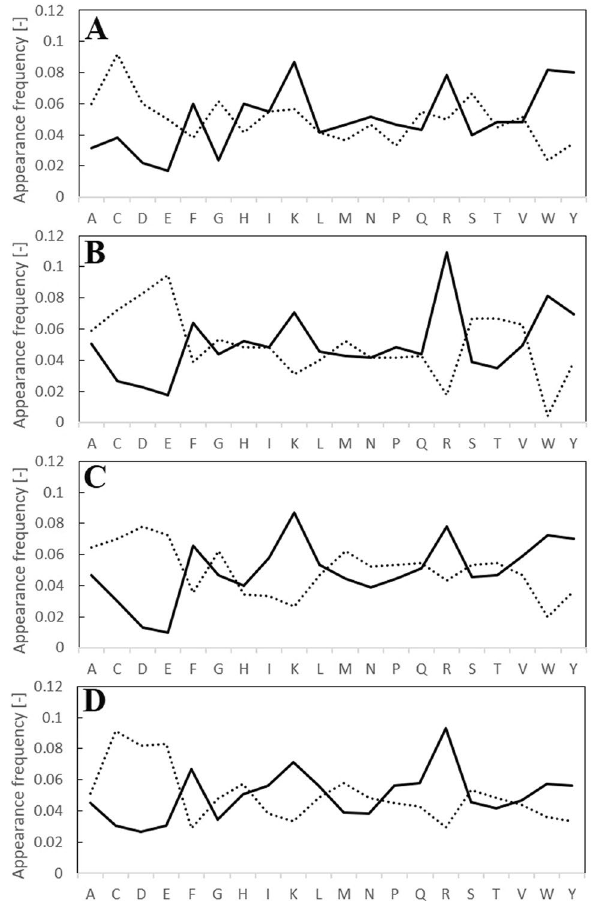
Figure 3. Appearance frequency of amino acid residues for 150 positive (solid lines) and 150 negative (dotted lines) peptides [( A ) 4-mer, ( B ) 5-mer, ( C ) 6-mer, ( D )